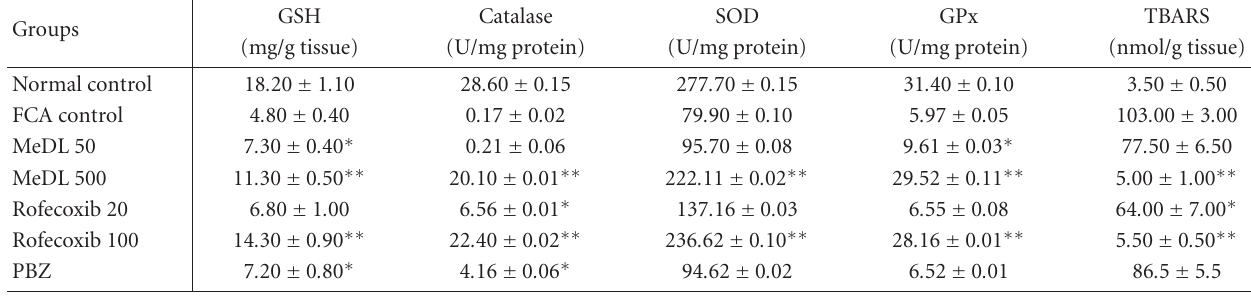
Table 2: E ff ect of drugs on parameters of oxidative stress in FCA-induced monoarthritis. Values given are mean ± standard error of the mean ( n = 6).